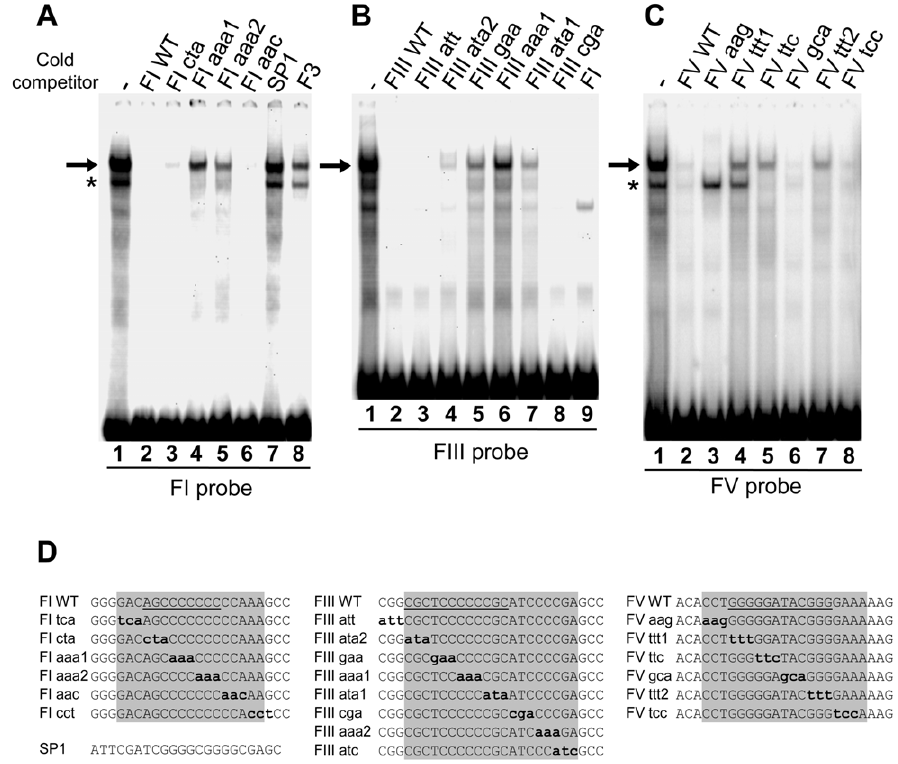
Figure 4. Nuclear proteins specifically interact with the dG-dC strings at HS4 footprints I, III, and V. (A–C) Gel mobility shift analysis of interactions between chicken adult erythrocyte nuclear extract and 32 P-labelled FI (A), FIII (B), and FV (C) oligonucleotide duplexes. Unlabelled competitor duplexes (indicated above each lane) were added at 50 fold molar excess. Arrows indicate footprint sequence-specific complexes. Asterisks indicate a non-specific FI complex in (A) and an FV complex that was not pursued further due to inconsistent abundance in (C). (D) Sequences present in competitor oligonucleotides. Mutations shown in bold lower case. Footprinted bases are indicated by shading. Bases that are essential for maximal binding are underlined; mutations of other bases had no effect on binding (A–C, data not